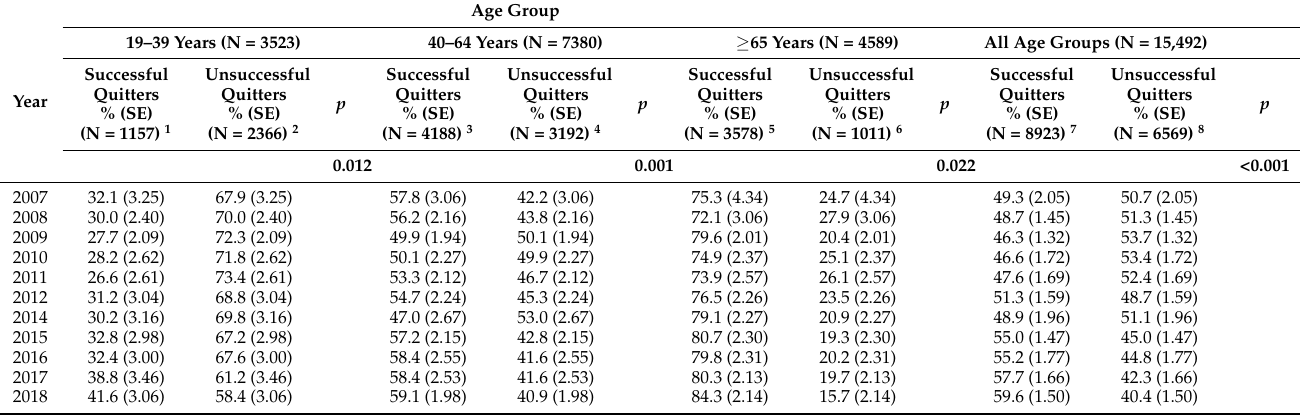
Data have been presented as weighted percentage (standard error, SE). The p -value was determined using the Rao–Scott chi-square test. Data were not collected in 2013. 1 Weighted n = 1,304,511 (31.5%); 2 Weighted n = 2,832,741 (68.5%); 3 Weighted n = 3,442,040 (54.7%); 4 Weighted n = 2,851,877 (45.3%); 5 Weighted n = 1,513,902 (78.6%); 6 Weighted n = 412,976 (21.4%); 7 Weighted n = 6,260,453 (50.7%); 8 Weighted n = 6,097,593